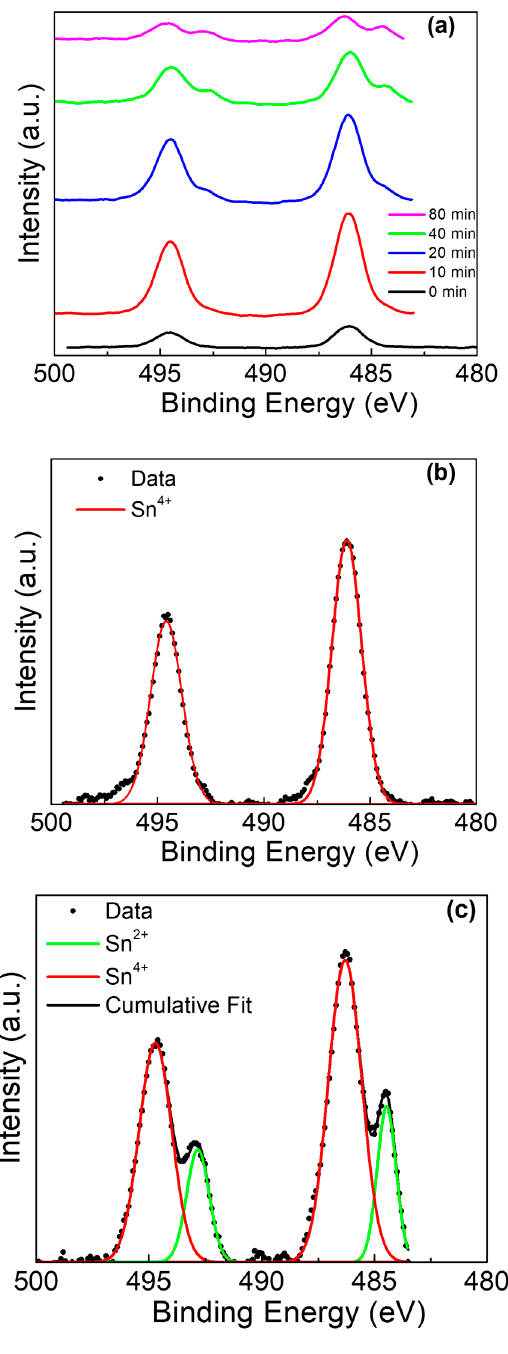
Figure 6. Sn 3d XPS of Ti rod with amalgam at pH 2. ( a ) Sn 3d peak at various sputter times, ( b ) deconvolution of 0 min sputter time, and ( c ) deconvolution of 90 min sputter time.